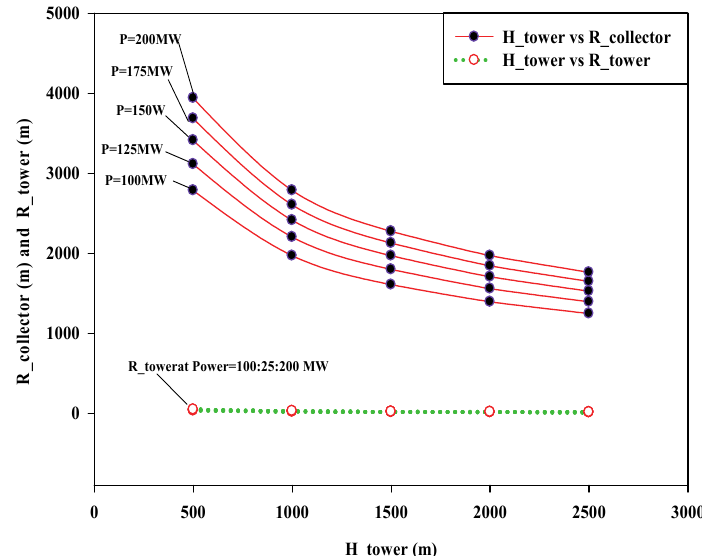
Figure 12. Effect of variation in tower height ( H Tower ) on collector radius ( R Collector ) and tower radius ( R Tower ) for fixed power output of SUTPP.